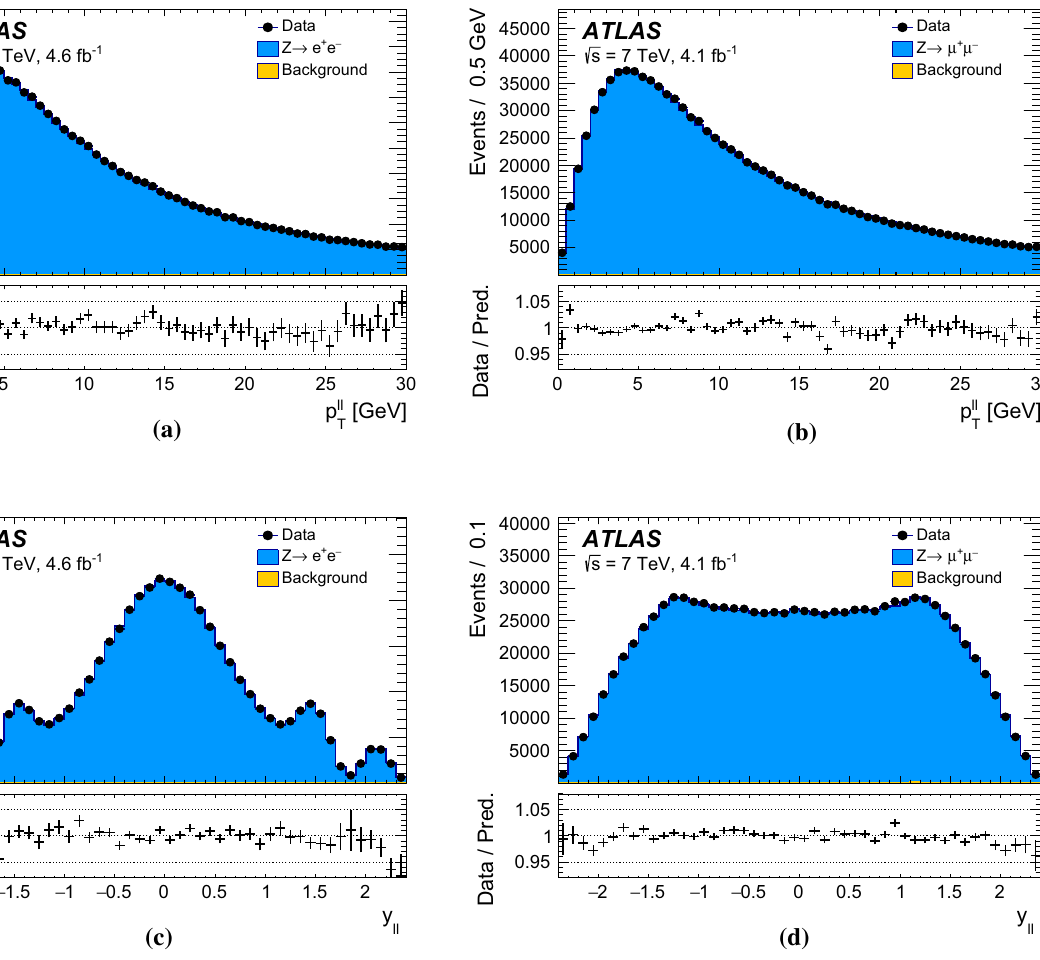
Fig. 14 The a , b p (cid:7)(cid:7) and c , d y (cid:7)(cid:7) distributionsin Z -bosoneventsforthe T a , c electron and b , d muon decay channels. The data are compared to the simulation including signal and backgrounds. Detector calibration and physics-modelling corrections are applied to the simulated events.